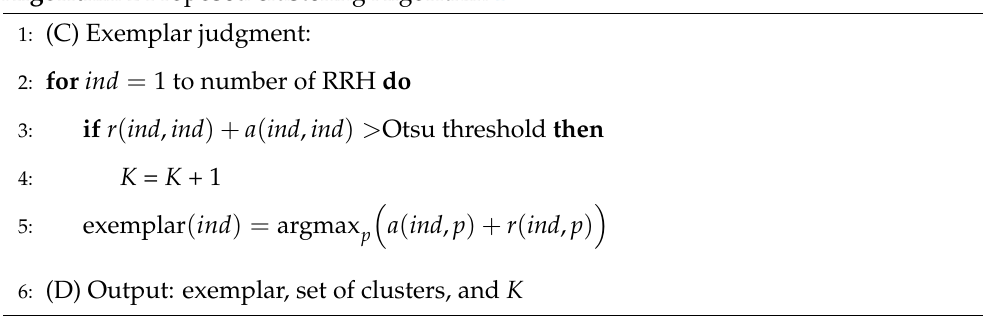
Algorithm 2 Proposed clustering Algorithm 1